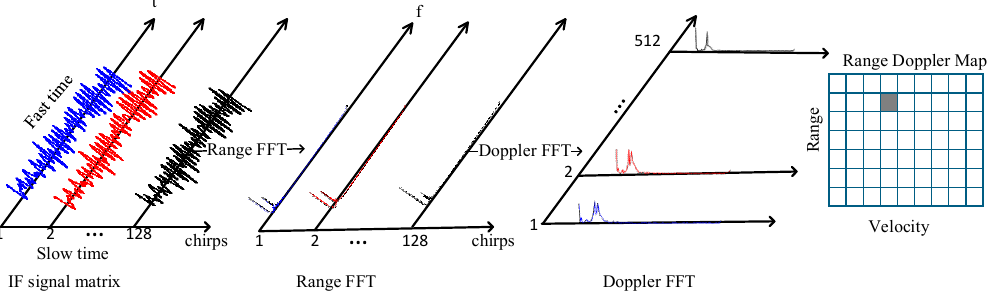
Figure 4. Range–Doppler FFT calculation process to generate a traditional Range–Doppler Map (RDM).